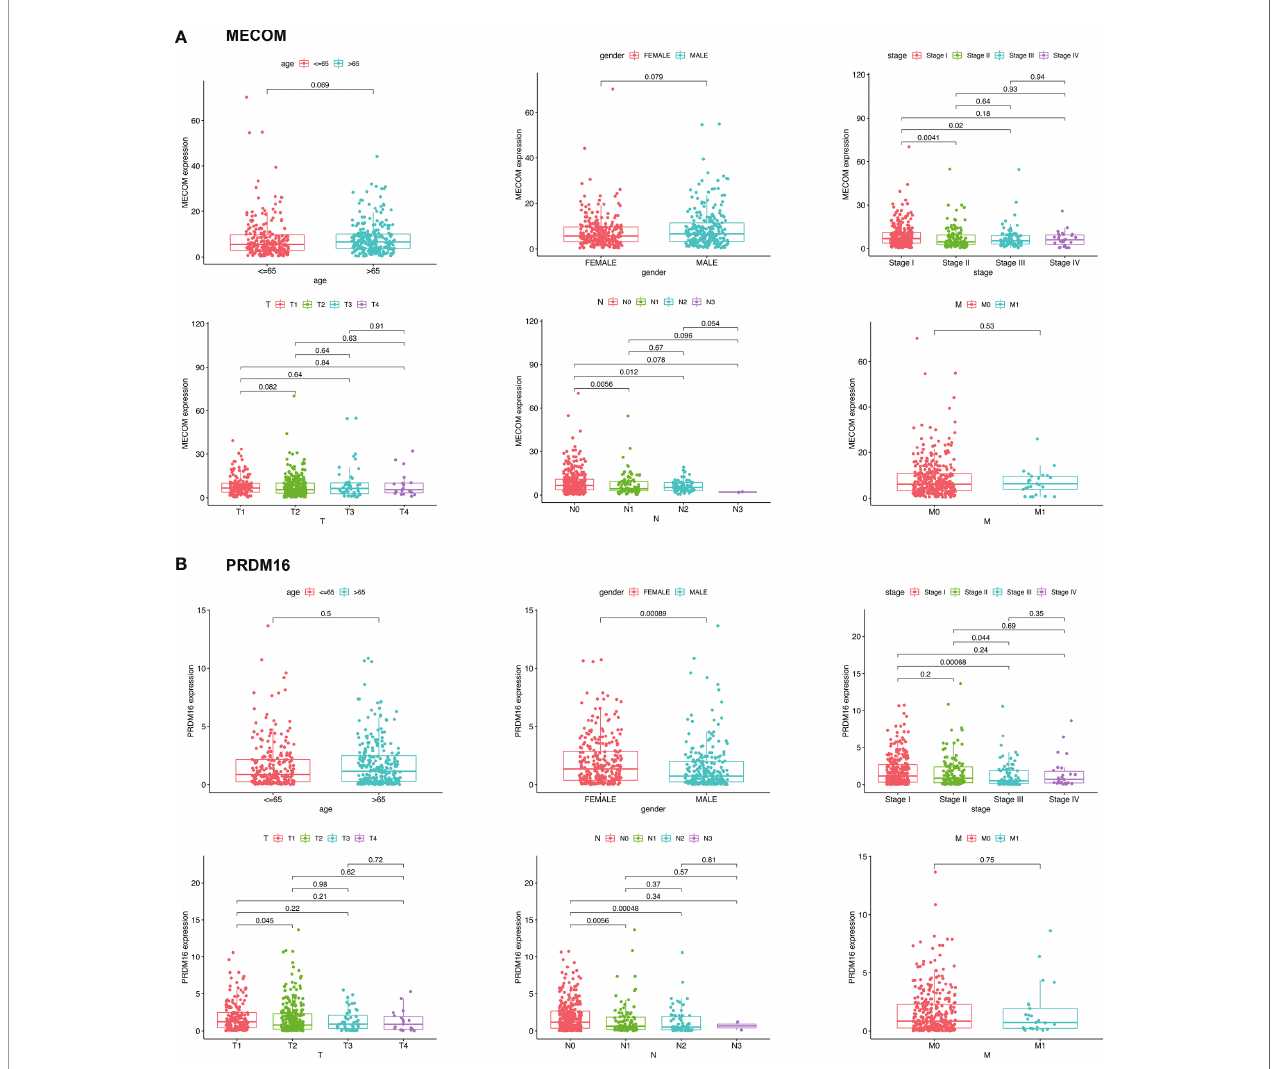
FIGURE 3 | Expression levels of MECOM (A) and PRDM16 (B) in different clinicopathological characteristics of LUAD patients. MECOM, MDS1 and EVI1 complex locus, also called PRDM3; PRDM16, PR domain containing 16, also called MEL1; LUAD, lung